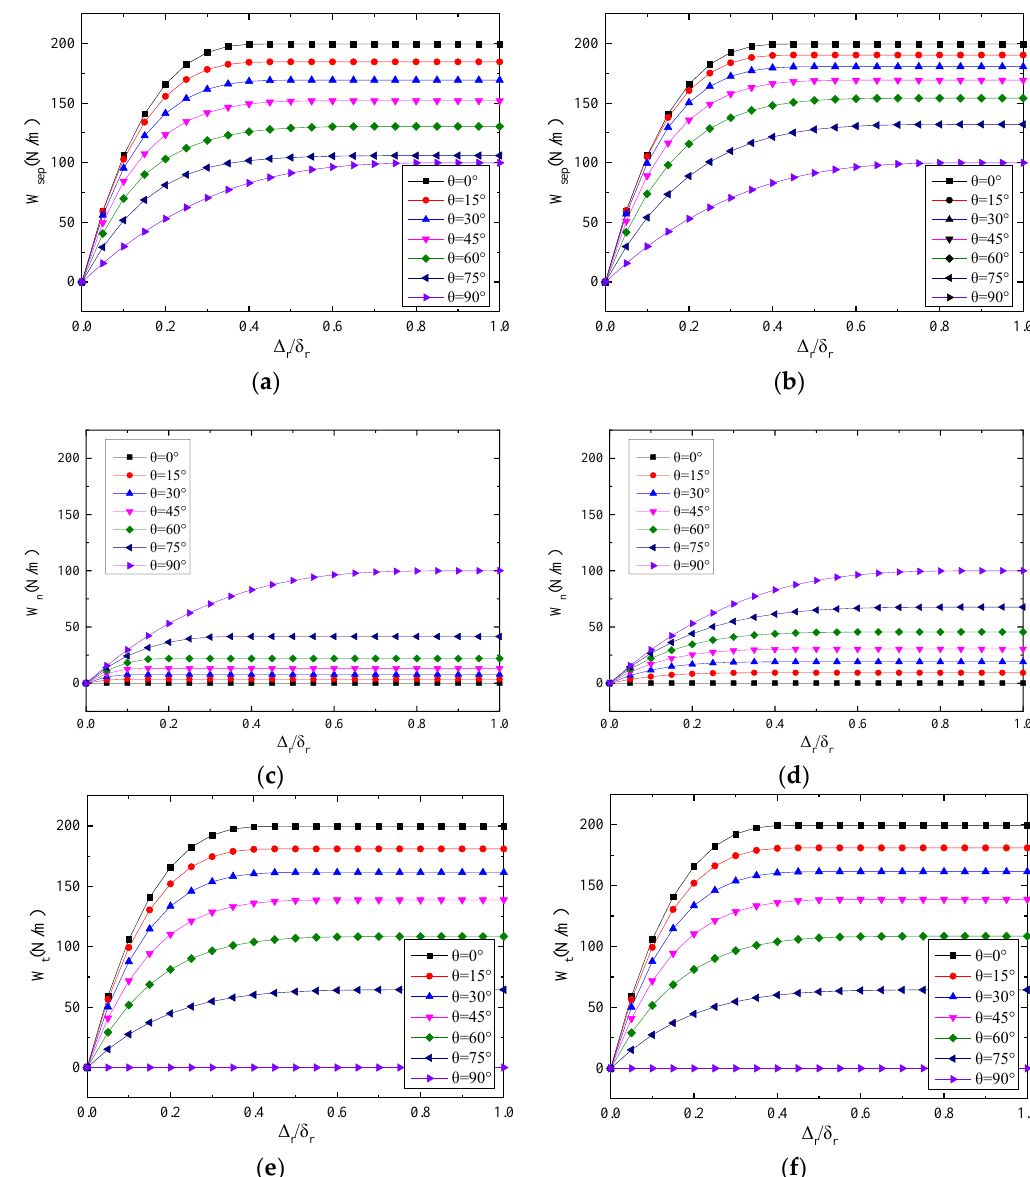
Figure 5. Proportional separation path ( Δ 𝑟 ) with the separation angle ( 𝜃 ). Before separation ( a ); after separation ( b ).